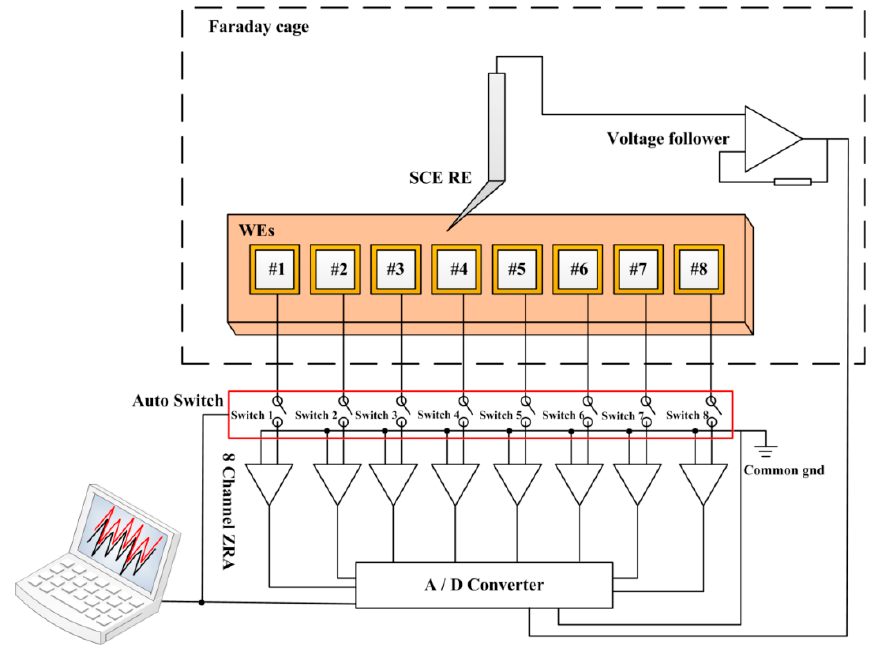
Figure 2 The measurement principle diagram of the coupled multi-electrode array sensor system. Figure 2. The measurement principle diagram of the coupled multi-electrode array sensor